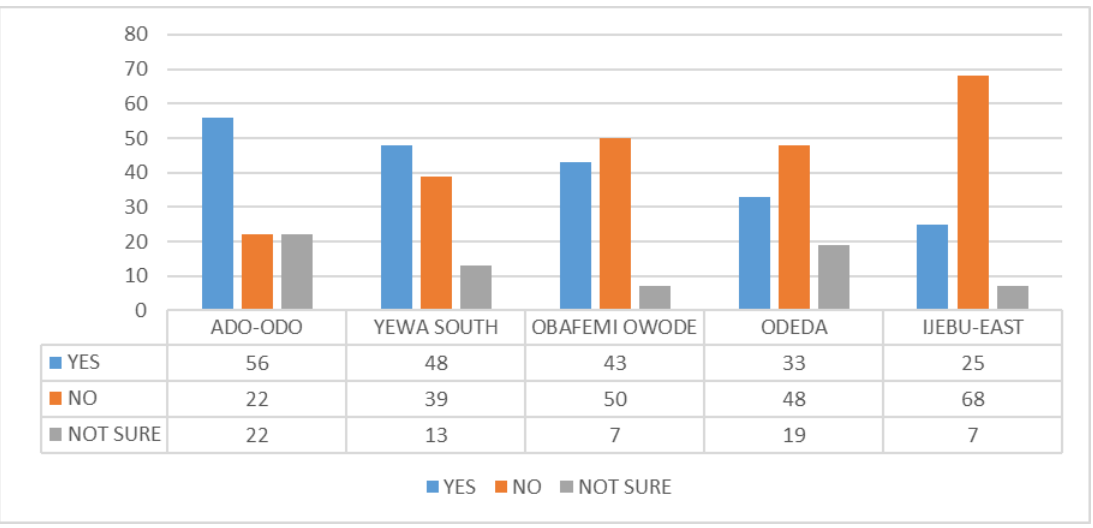
Figure 5. Responses on if solid waste collection services are efficient.